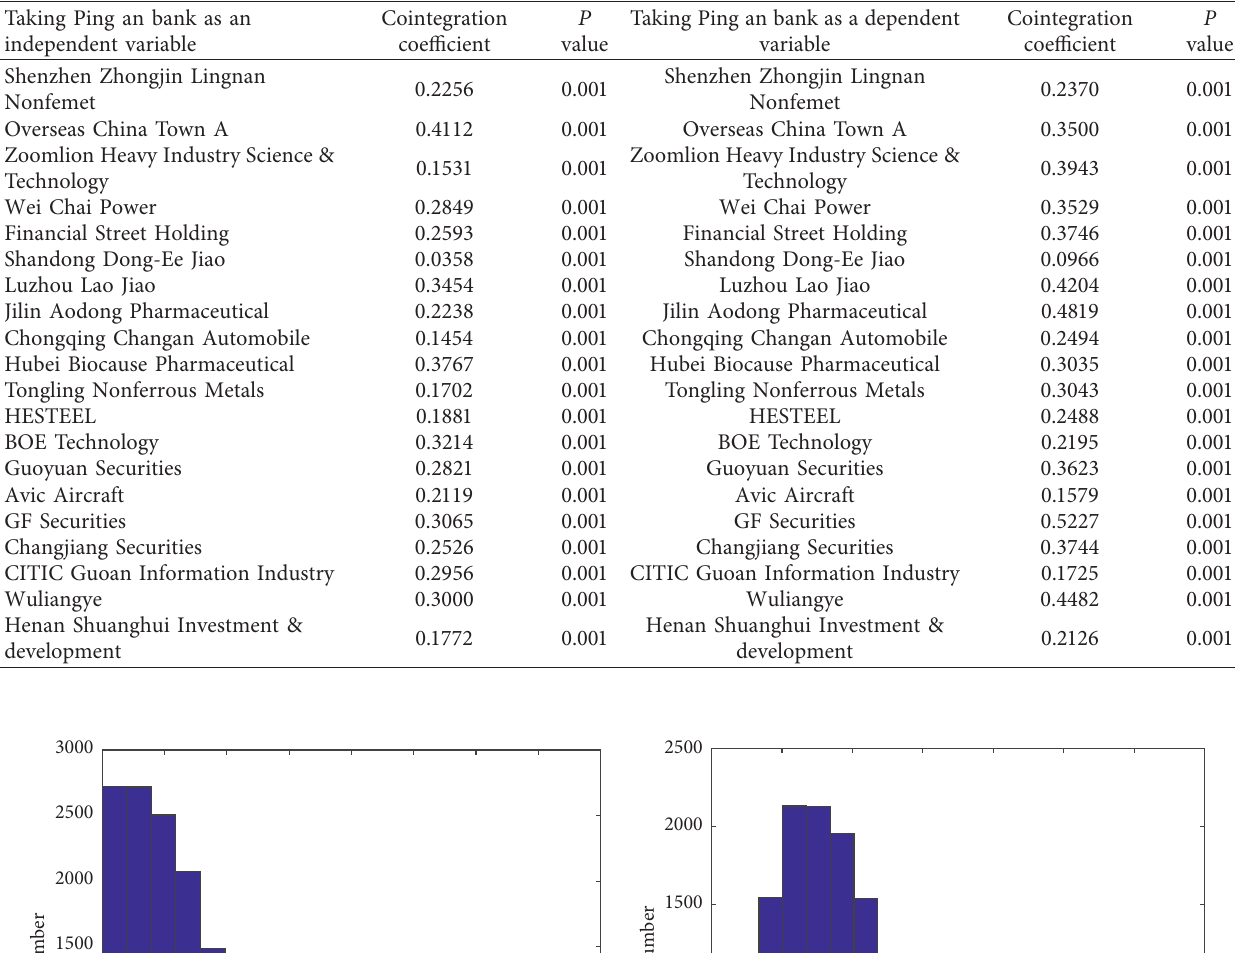
Table 3: Cointegration coefficient of Ping An Bank with other selected stocks during 2017-2018. Taking Ping an bank as an